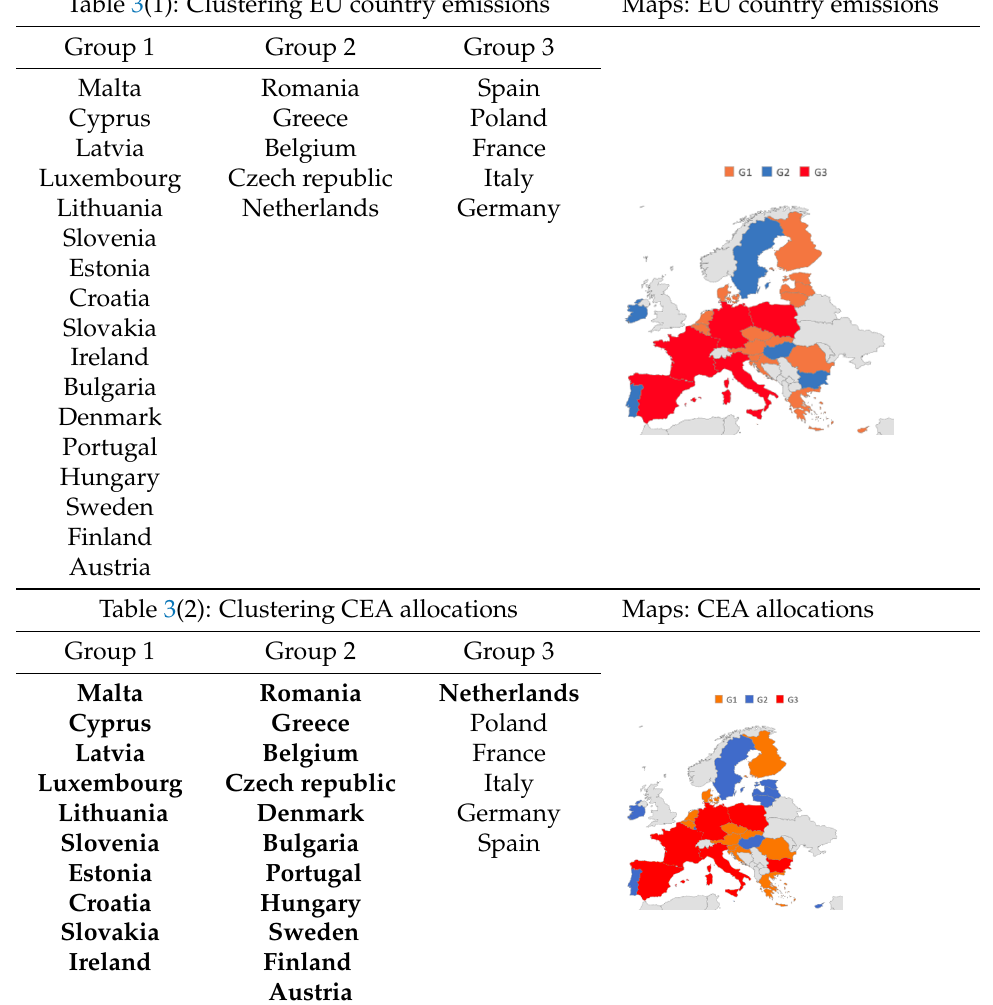
Table 3(3): Clustering WCEA GDP allocations Maps: WCEA GDP